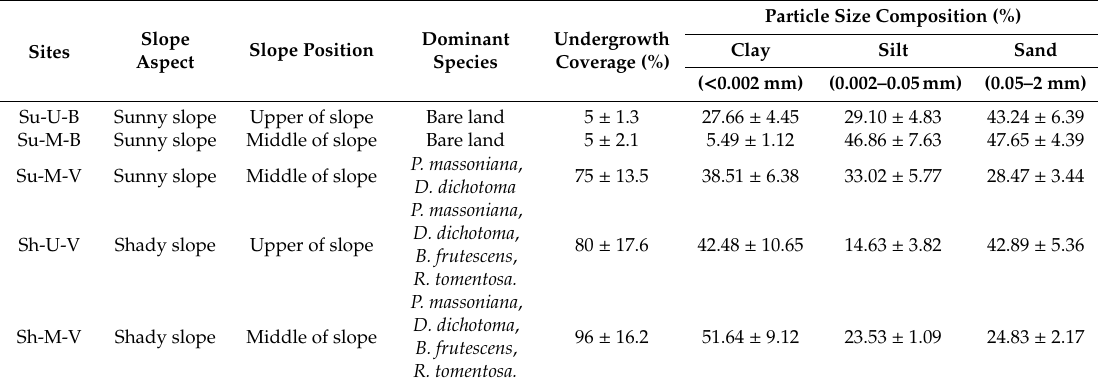
Table 1. The slope information, dominant species, undergrowth coverage, and soil particle size composition (USDA) for the five experimental